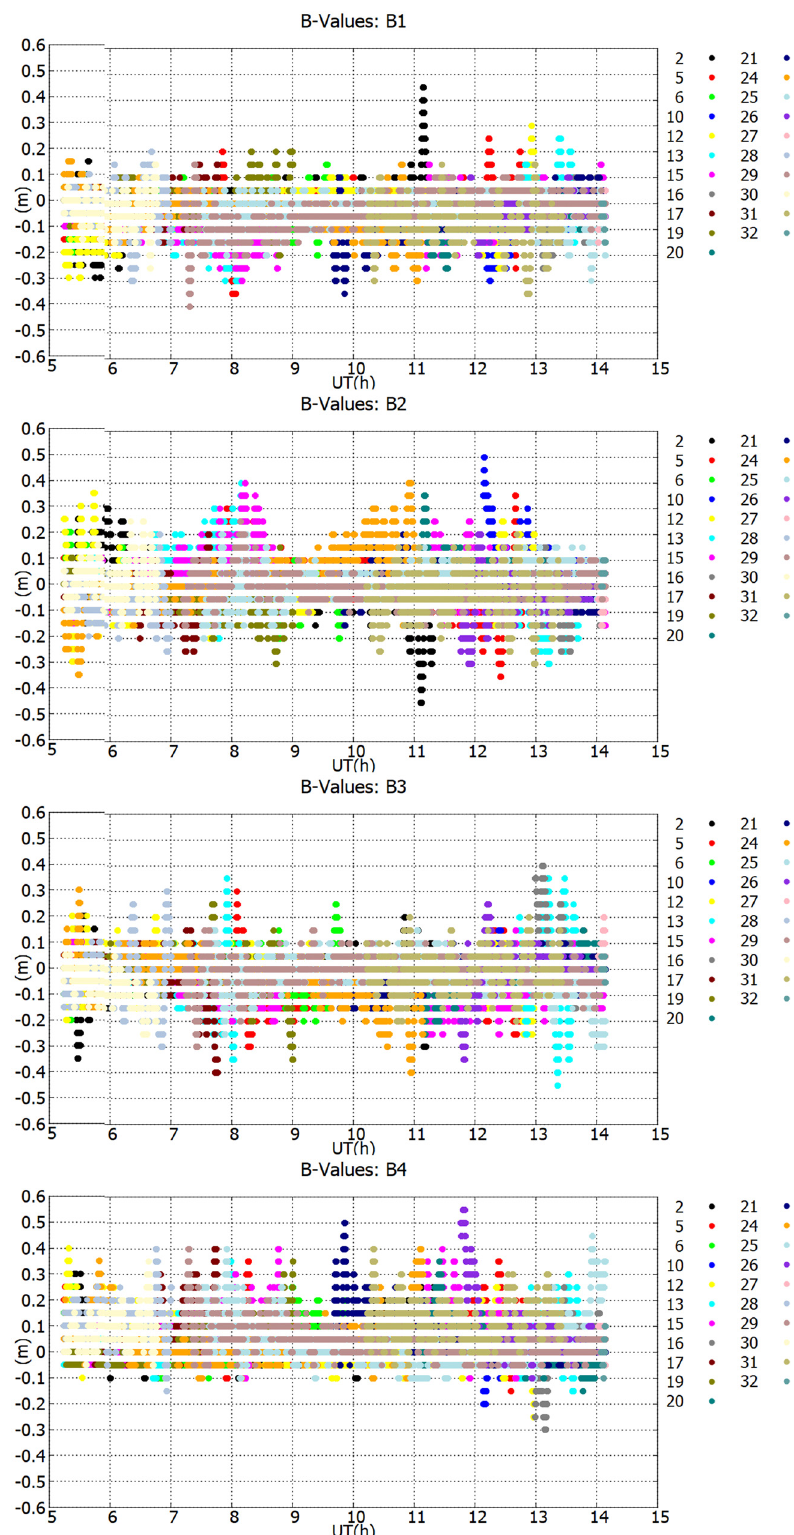
Figure 8: B - Values parameters for each satellite and reference